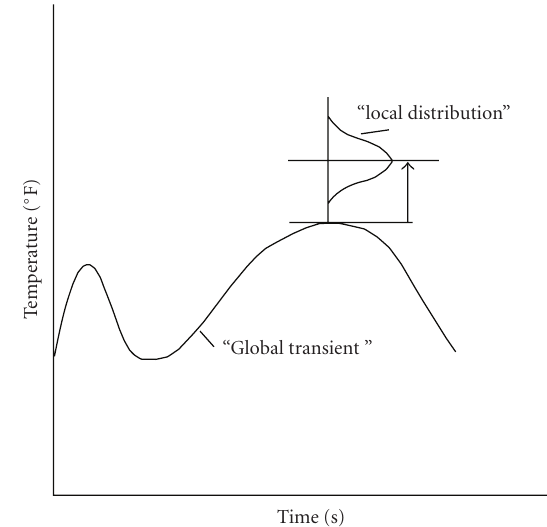
Figure 4: Relationship of local hot spot distribution to global pre-